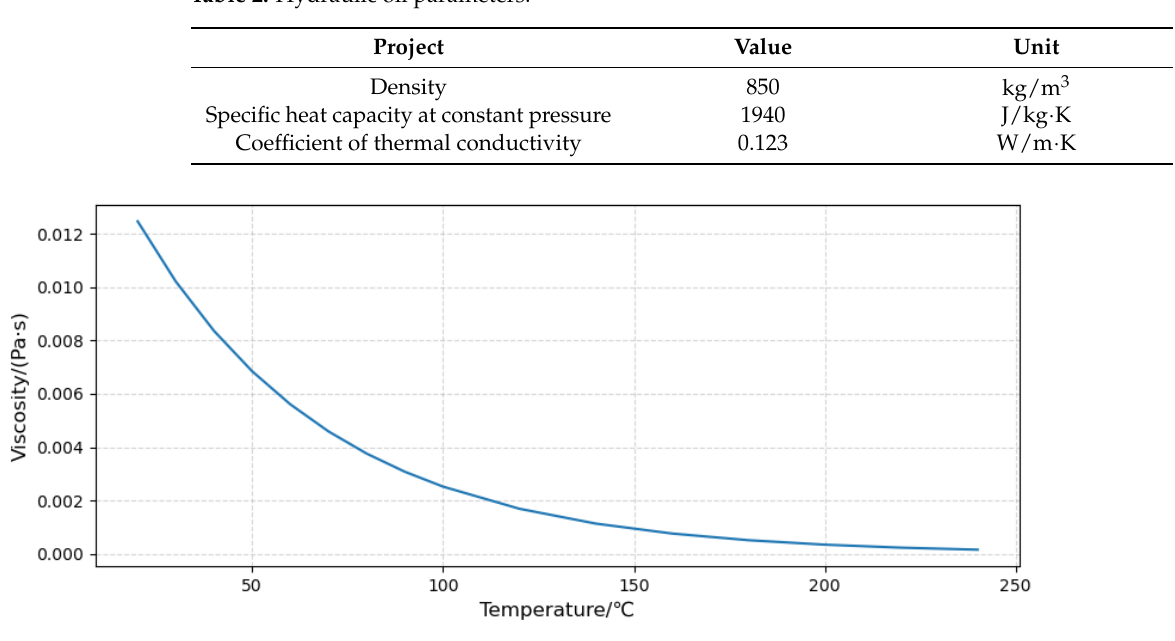
Table 2. Hydraulic oil parameters.